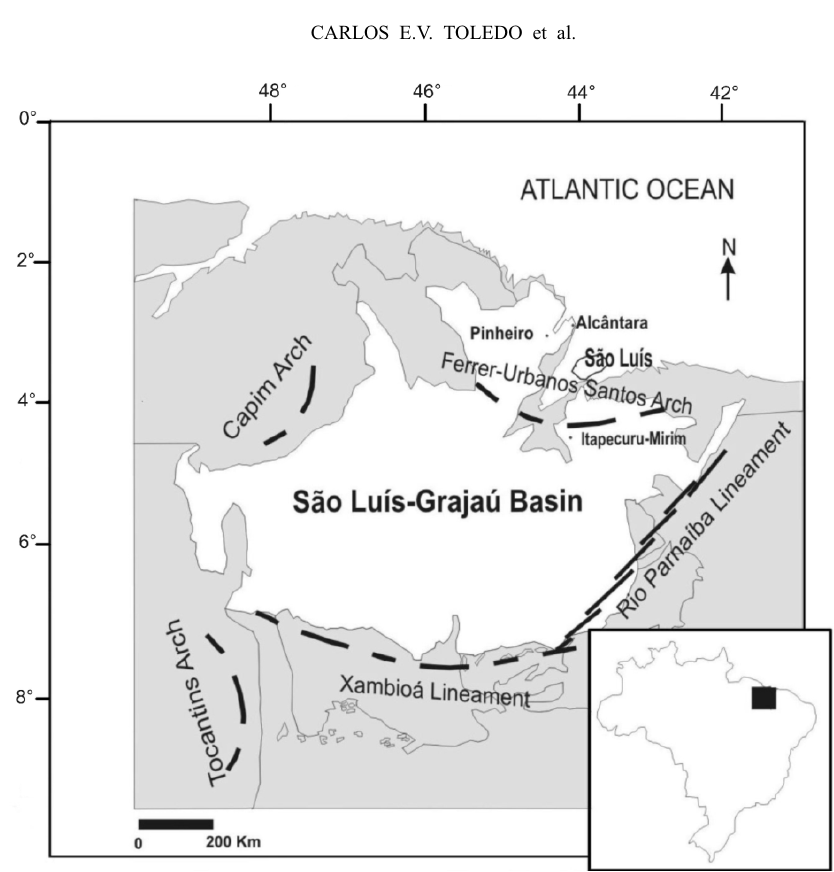
Fig. 1 – Map of Northern Maranhão state showing main geological landmarks of the São Luís – Gajaú Basin, and the localization of the Alcântara Municipality (adapted from Rossetti